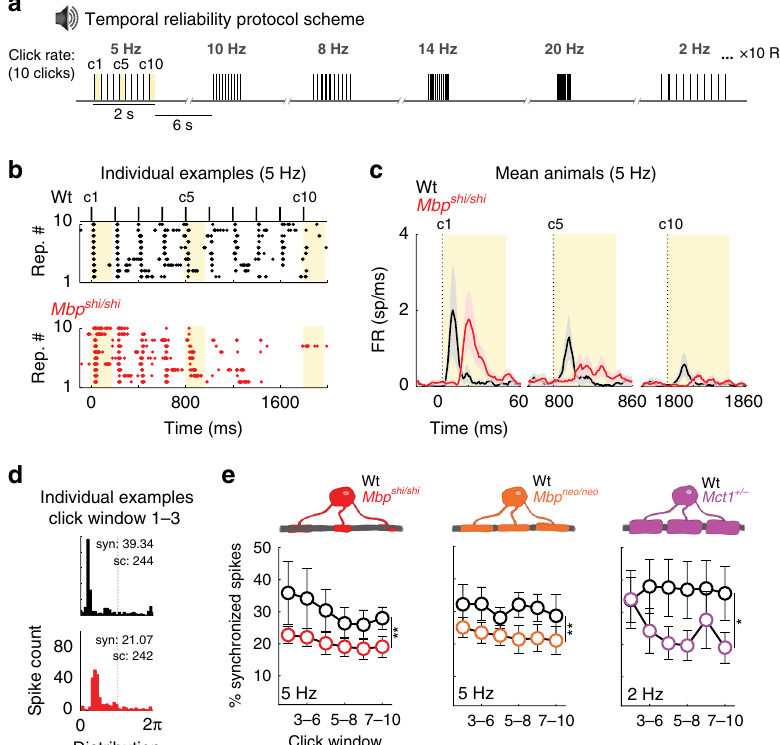
Fig. 2 Temporal reliability is affected in mice with either dysmyelination or an oligodendrocyte-speci fi c metabolic impairment. a Schematic of the click- rate-tracing protocol used to test temporal reliability. Blocks of ten clicks are played at different rates in random order. Each rate is repeated ten times. Analysis in c focuses on the highlighted (yellow) clicks 1, 5, and 10 (c1, c5, and c10). b Example raster plot of ACx responses (each dot = 1 spike) to ten clicks at 5 Hz across the ten stimulus repetitions in a Wt (upper, black) and an Mbp shi/shi mouse (lower, red). Mbp shi/shi animals show a steeper decay on spiking activity across clicks compared to Wt. c Mean peristimulus time histogram (PSTH) of responses to clicks 1, 5, and 10, at 5 Hz for Wt (black, n = 10) and Mbp shi/shi (red, n = 13) animals. The thick line shows the mean of all recorded animals and the shaded area depicts the S.E.M. Click onset is indicated by dashed lines. While responses to the fi rst click are similar in amplitude in Wt and Mbp shi/shi animals (with the expected delay in Mbp shi/shi ), a strong reduction of response strength is seen in Mbp shi/shi mice with increasing clicks. d Individual examples of spike synchrony plots for Wt (black, top) and Mbp shi/shi (red, bottom) were taken from the fi rst sliding window (see panel e clicks 2 – 5). Syn: synchrony %, sc: spike count. e Quanti fi cation of spike synchrony in sliding windows of four clicks (clicks 2 – 5, 3 – 6, 4 – 7, 5 – 8, 6 – 9, and 7 – 10). Onset responses to click 1 were excluded. Leftmost: signi fi cant reduction in spike synchrony between Mbp shi/shi mice (red, n = 11) and Wt (black, n = 5 mice) at 5 Hz (one-way ANOVA, F (1,76) = 10.17, P = 0.002). Middle: signi fi cant reduction also seen between Mbp neo/neo mice (orange, n = 6 mice) and Wt (black, n = 8 mice) at 5 Hz (one-way ANOVA, F (1,86) = 10.94, P = 0.0014). Right: signi fi cant difference between Mct1 + / − mice (purple, n = 6 mice) and Wt (black, n = 8 mice) at 2 Hz (one-way ANOVA, F (1,78) = 6.74, P = 0.011). Source data are provided as a Source Data fi